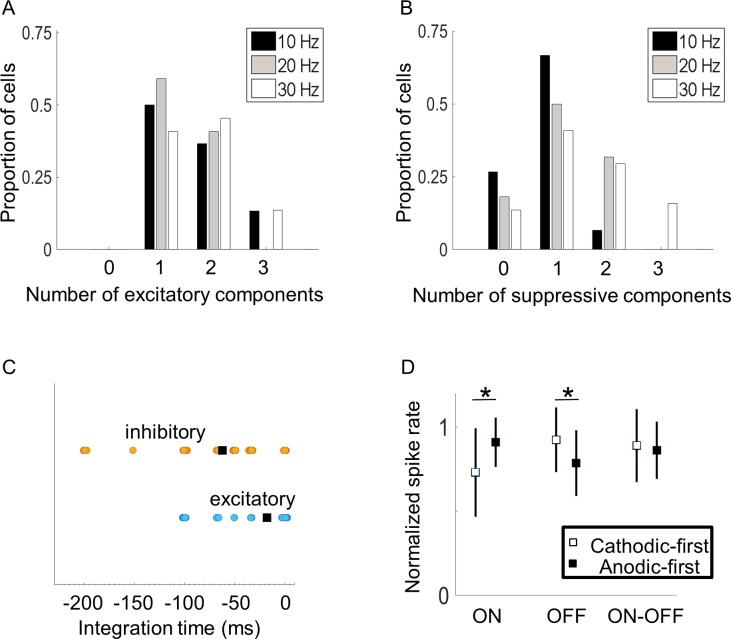
Electrical receptive field properties.A) Proportions of cells with up to three excitatory components. B) Proportions of cells with up to three suppressive components. C). The temporal windows over which suppressive and excitatory ERFs affected cell responses, thus indicating duration of stimulus integration time. Excitatory ERFs tended to occur within a short latency from the response (blue circles). Suppressive ERFs tended to extend over a long duration, which was variable from cell to cell (orange circles). The squares represent the means for all cells. D) RGC preference to cathodic-first or anodic-first stimulation. Squares represent means and lines indicate ±1 standard deviation. Stars denote significant differences (p < 0.05).